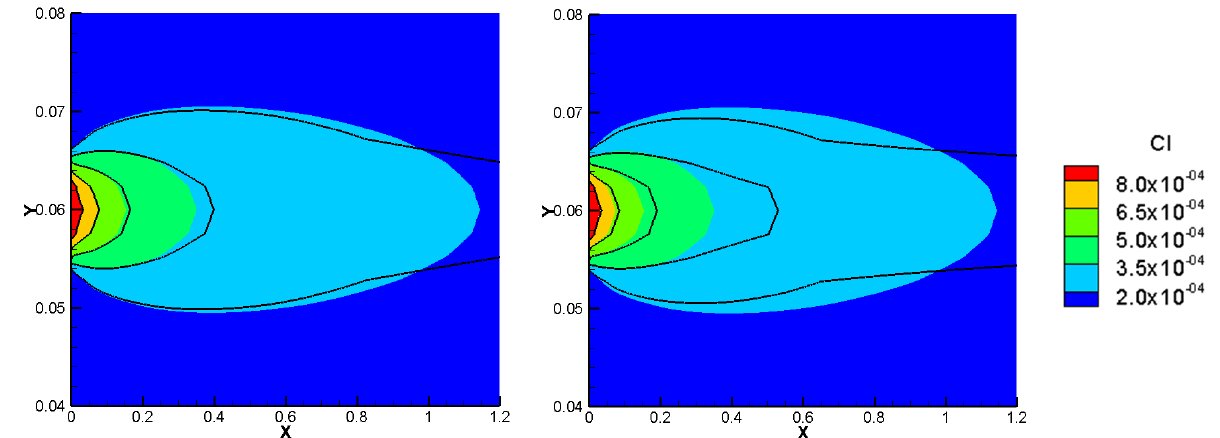
Figure 4. Comparison of total concentration results of the NPP (Colors) and NC (Lines) models for simulation of benchmark 3-2D with sorption: low sorptivity (test case 1 —left ), high sorptivity (test case 2 —right ).